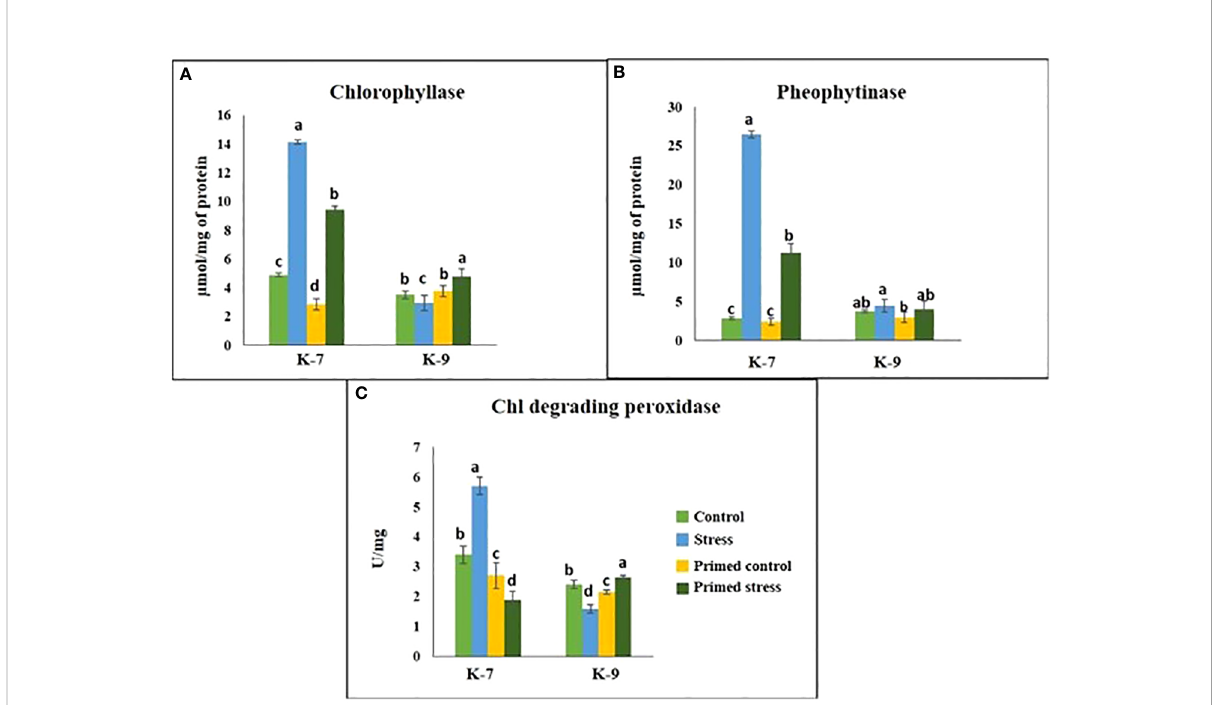
FIGURE 9 Effect of melatonin priming on the activities of chlorophyll degrading enzymes in drought-sensitive (K-7) and drought-tolerant (K-9) varieties under drought stress. (A) Chlorophyllase; (B) Pheophytinase; and (C) Chlorophyll degrading peroxidase. Data represents mean values ± SD of